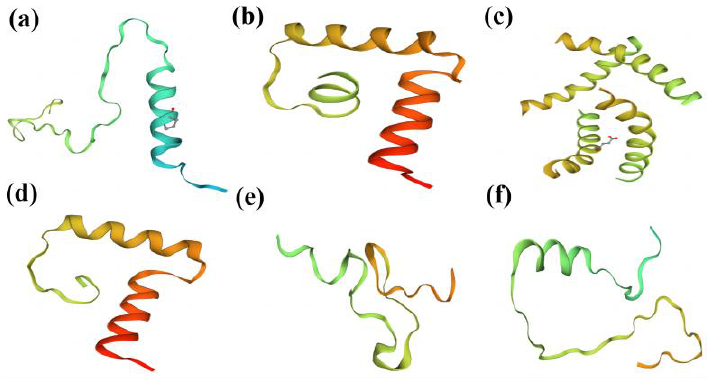
Figure 7. Part of Sanger sequencing results and GmFAD2 gene sequence mutation sites: ( a ) pBGK015Cas9-U6-FAD2-2A; ( b ) pBGK015Cas9-U6-FAD2-2B; ( c ) pBGK015Cas9-U6-FAD2-1A; ( d )